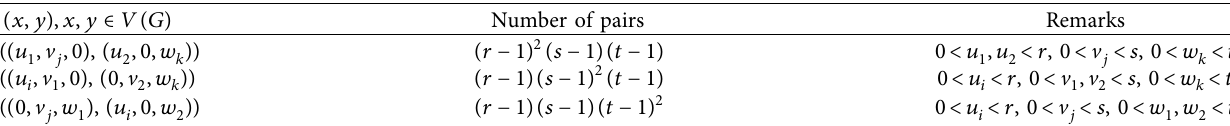
Table 18: Information related to the pair of nodes of G having distance